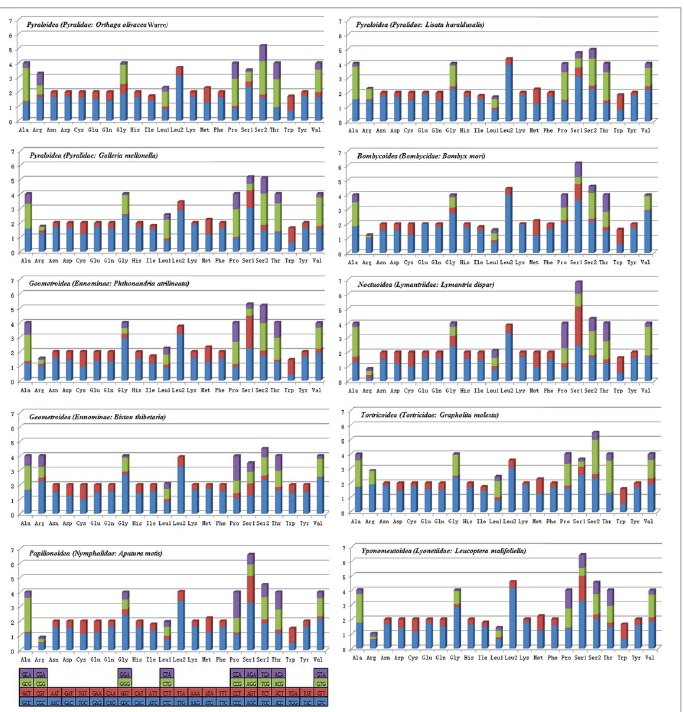
Fig 4. The Relative Synonymous Codon Usage (RSCU) of the eight superfamilies mitochondrial genome of Lepidoptera. Codon family is displayed on the X axis. Codons which are not present in mitochondrial genomes are indicated